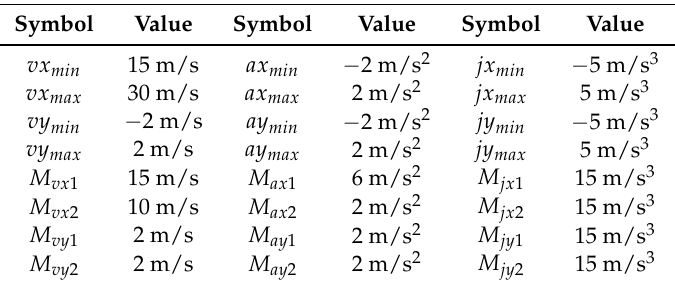
Table 1. Predefined Constraint